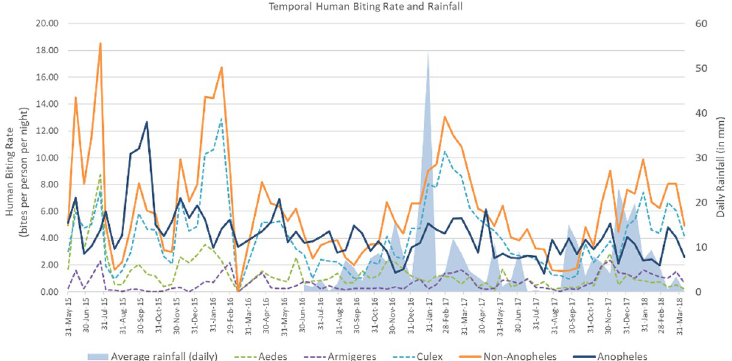
Fig 5. Seasonality of Culicidae mosquito genera related to rainfall over the 35 months of data